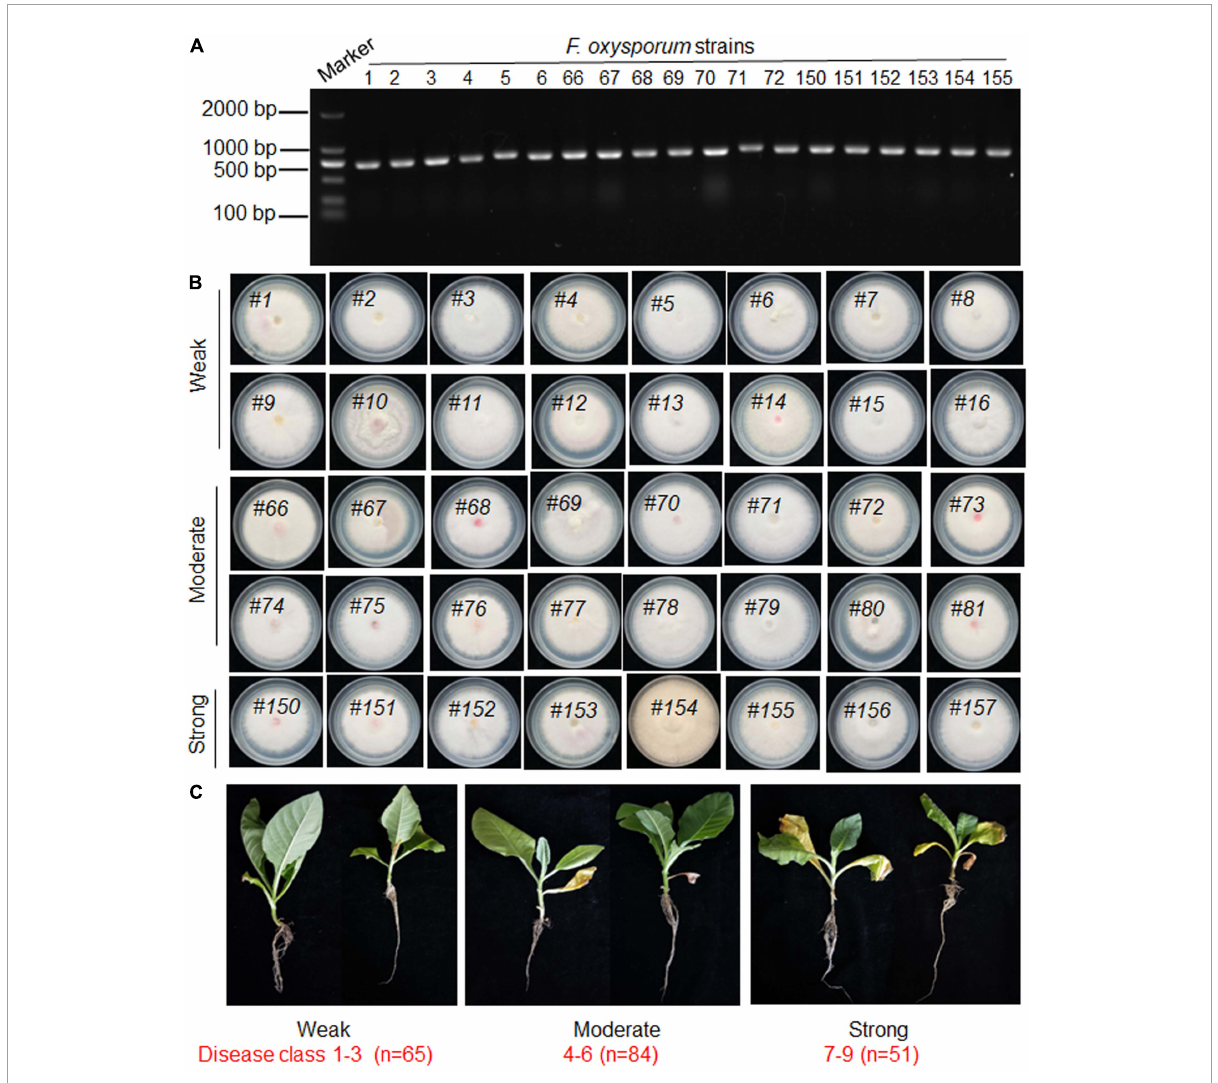
FIGURE1 Isolation, identification, and virulence classification of Fusarium oxysporum strains. (A) The Fusarium oxysporum strains were identified by PCR using Elongation factor (EF) gene-specific primers EF-1H and EF-2T. A molecular size marker is shown at the left-hand side of the panel. The line numbers of each virulence type were labeled. (B) Representative images of Fusarium oxysporum isolates grown on PDA medium. The line numbers of each virulence type were labeled. (C) Representative images of tobacco plants inoculated with Fusarium oxysporum strains (total n = 200) displaying weak (disease class 1–3; n = 65), moderate (disease class 4–6; n = 84), and strong (disease class 7–9; n = 51)